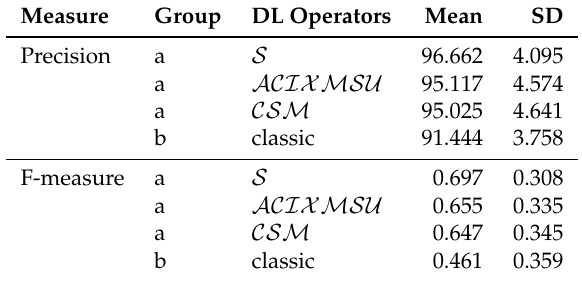
Table 10. Duncan test’s groups of datasets by the percentage of correctly-classified